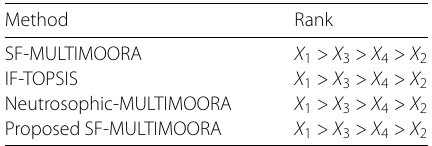
Table 4 The ranking of the alternatives using different methods